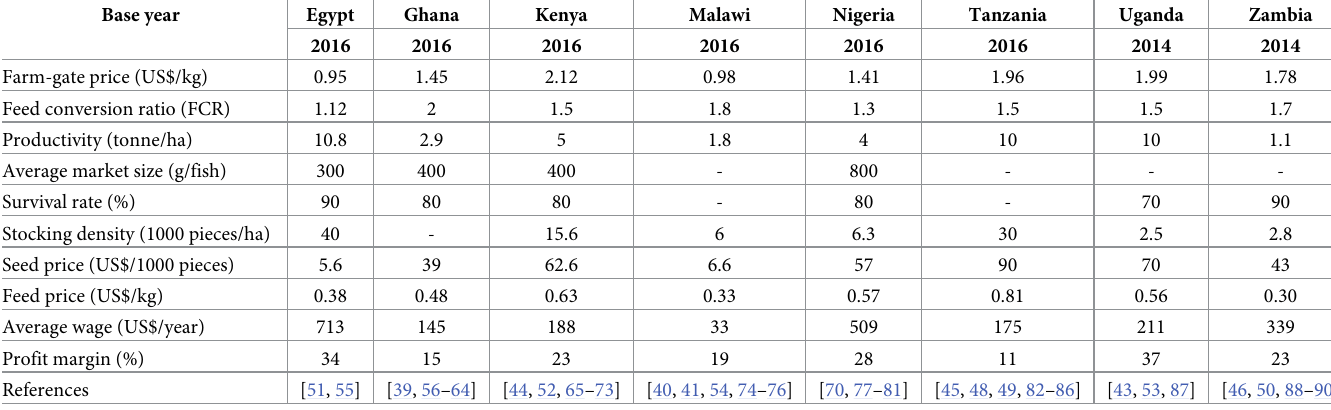
Table 2. Key parameters used for estimating the quantity and cost of key inputs in studied